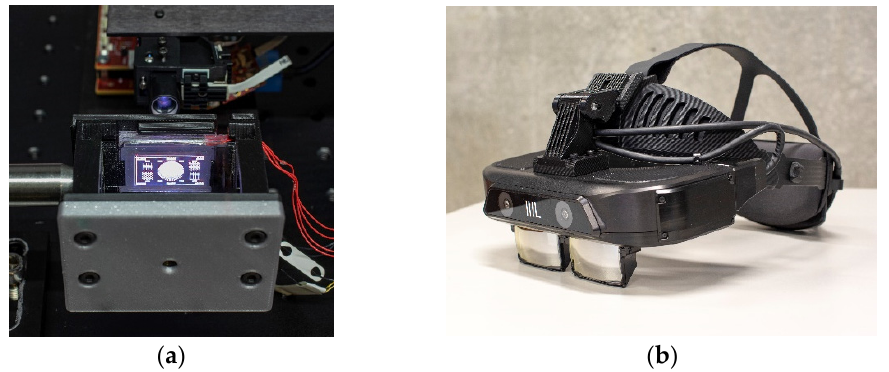
Figure 20. ( a ) Small-sized volumetric 3D screen and ( b ) multi-focal headset system housing the small-sized volumetric screen.